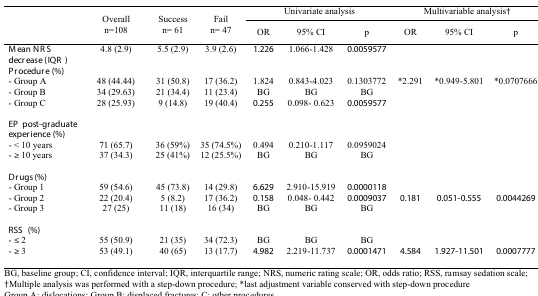
Table 2: Univariate and multivariable analysis evaluating the effect of each variable on the primary